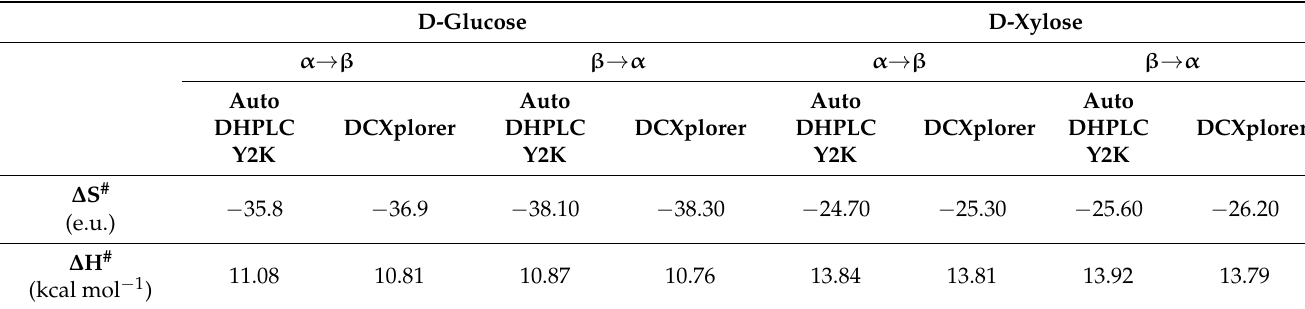
Table 4. Values of ∆ S # (e.u.) and of ∆ H # (kcal mol − 1 ) of the interconversion reactions under examination of D-Glucose and D-Xylose, obtained through van’t Hoff analysis.